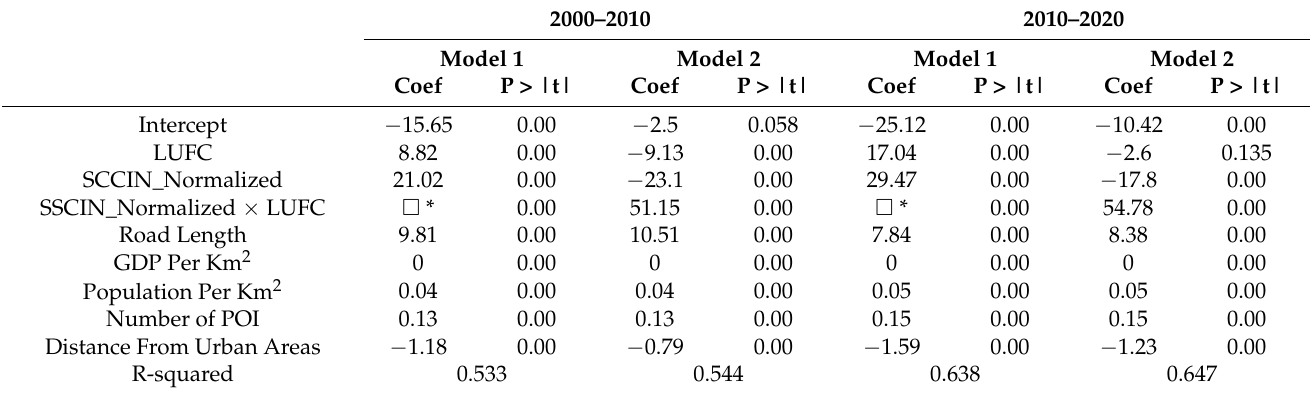
* Model 1 did not include this variable for comparison with Model